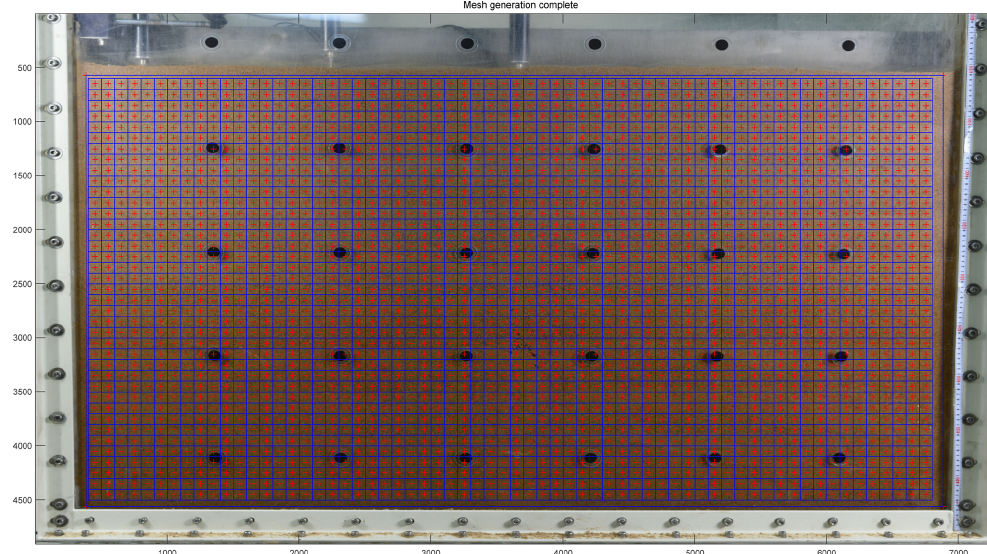
Figure 3. Selected pixel subsets and center points for digital image analysis.